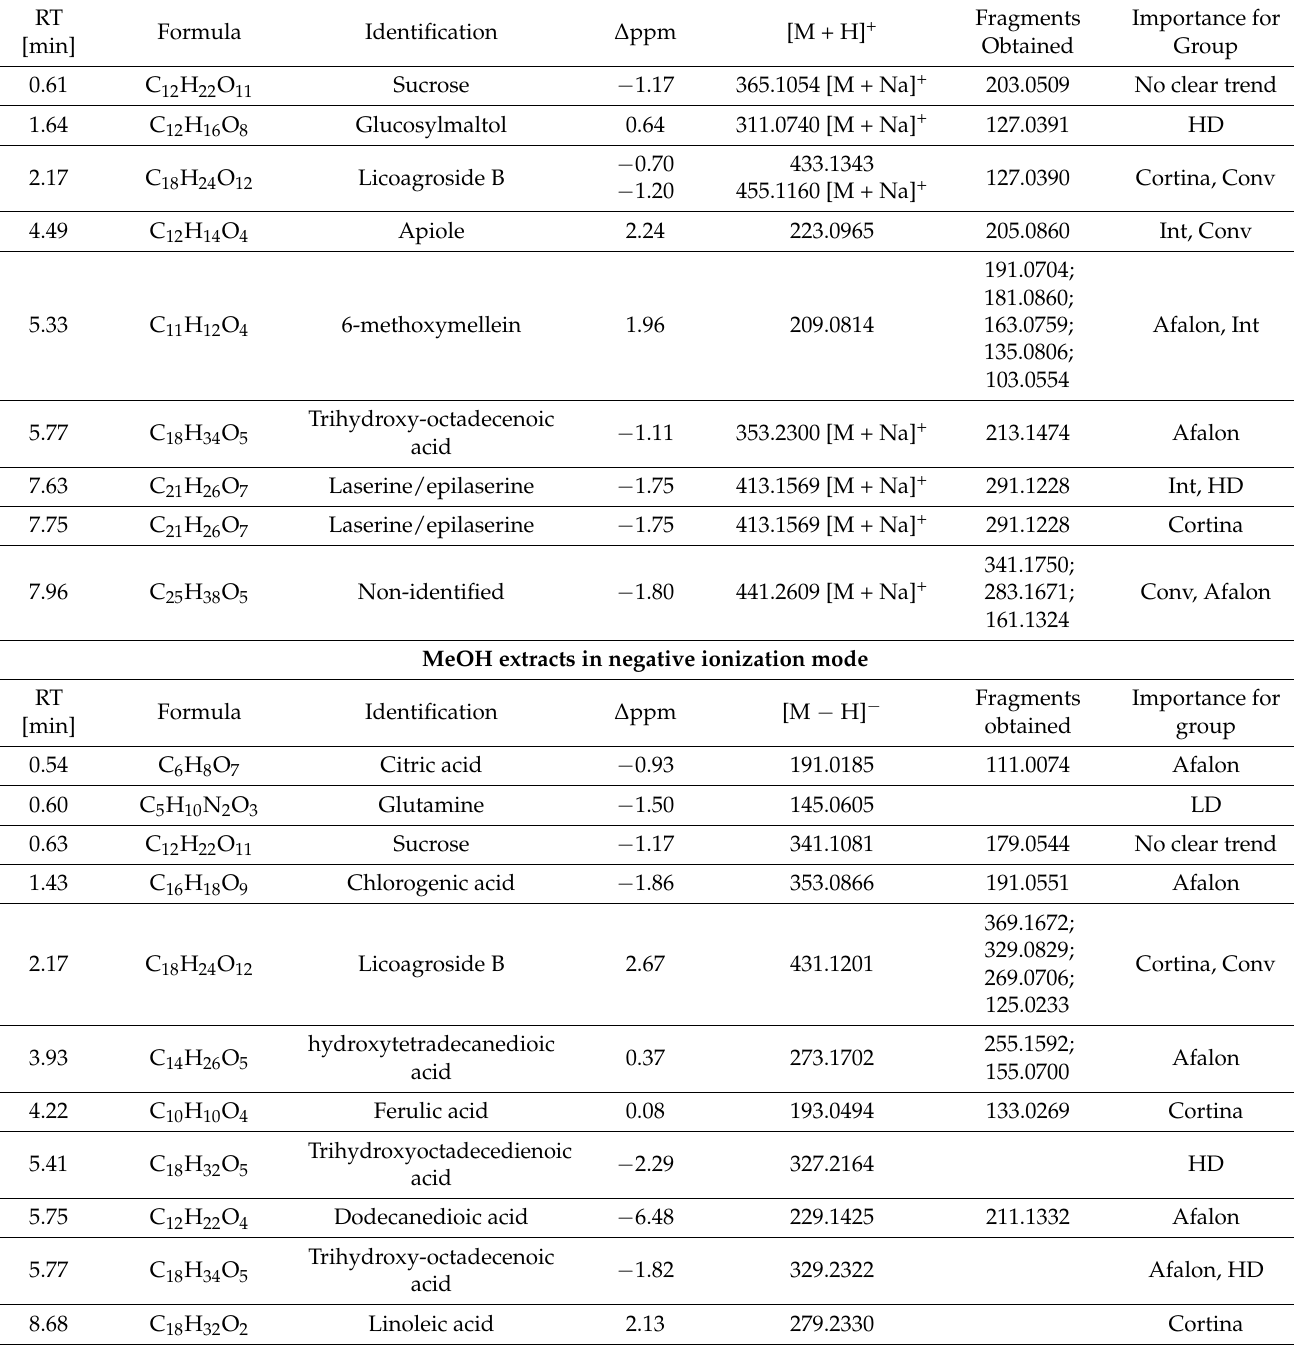
Table 2. List of compounds identified by UHPLC–Q-TOF-MS used for metabolomic analysis of carrot samples (methanol extracts). The compounds are sorted according to their retention time. (Conv = conventional, int = integrated, org = organic, LD = low seeding density, 6 × 10 5 seeds per ha, HD = high seeding density, 9 × 10 5 seeds per